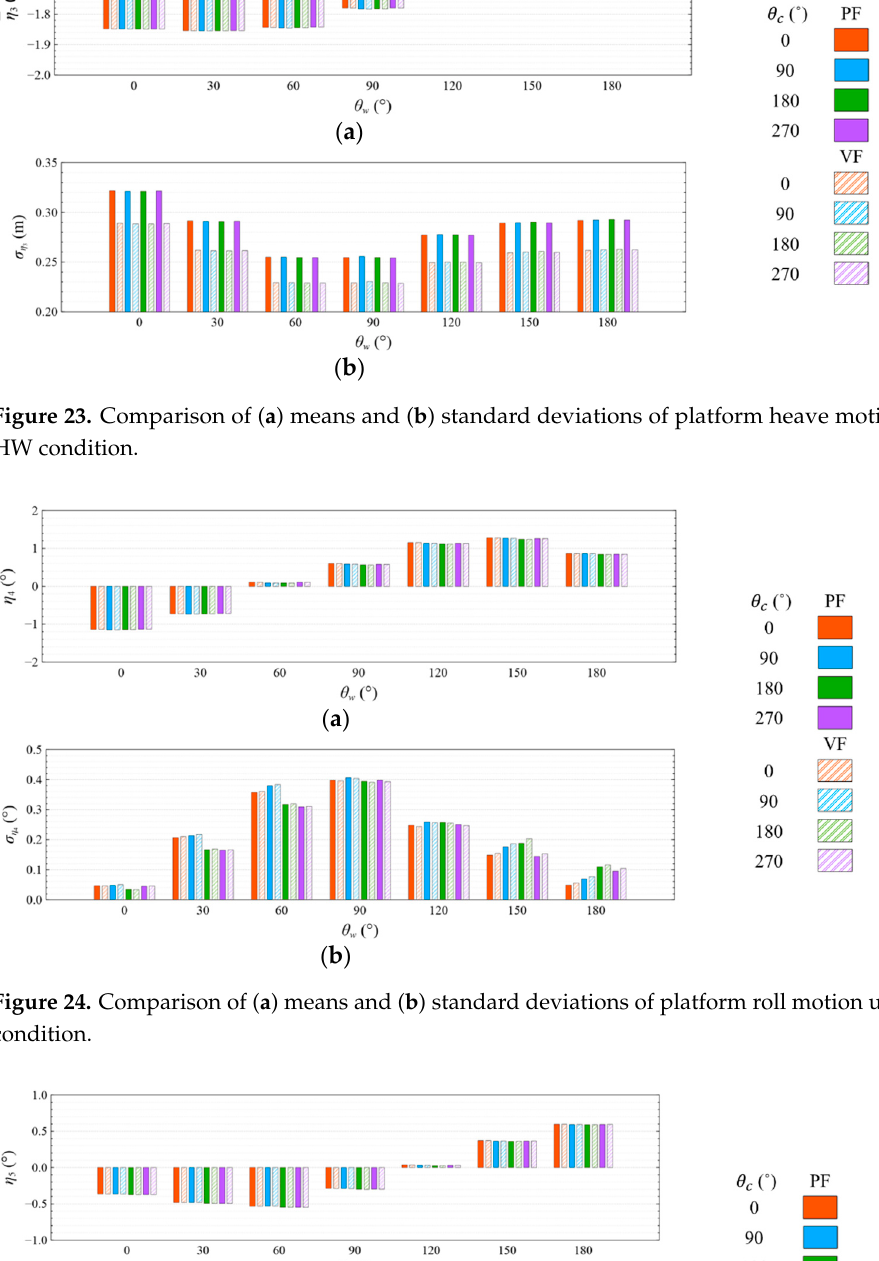
Figure 22. Comparison of ( a ) means and ( b ) standard deviations of platform sway motion under HW condition.